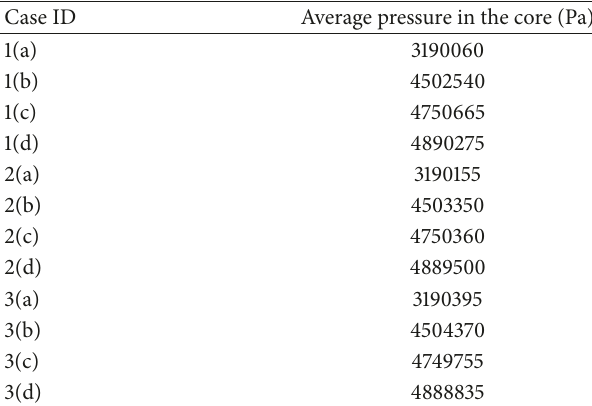
Table 11: Average pressure level in the core.